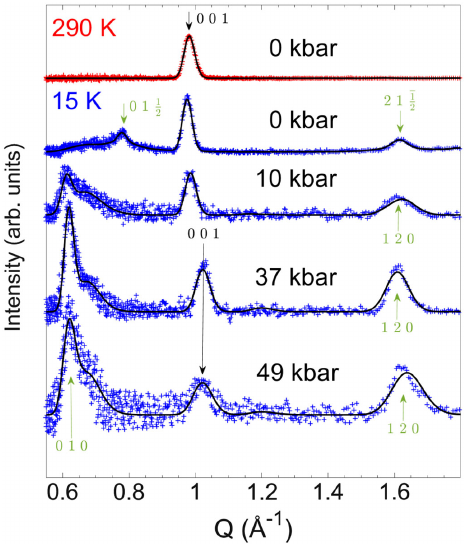
FIG. 5. Neutron diffraction patterns of FePS 3 , measured at selected pressures up to 49 kbar at room temperature and 15